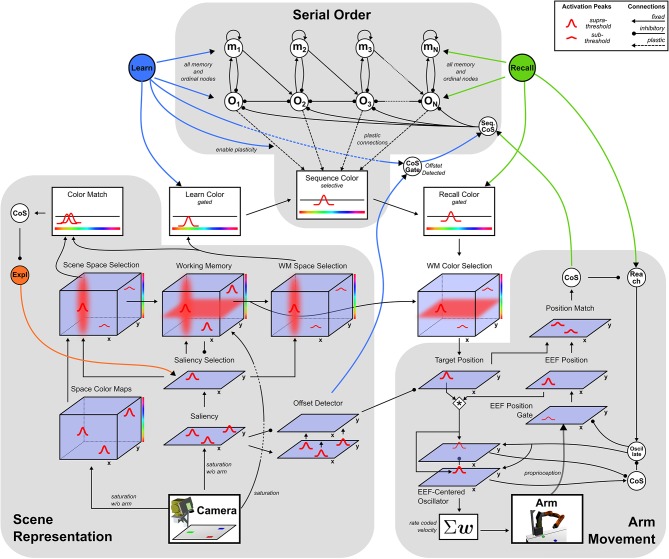
Sketch of the dynamic field network with its three sub-networks.